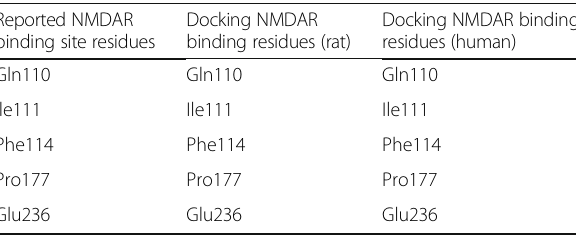
Table 4 Comparative tabulation of binding residues of reported NMDAR versus post-docking results Reported NMDAR binding site